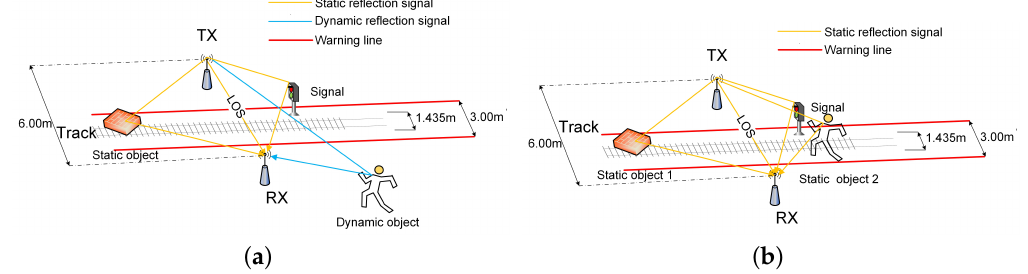
Figure 6. Foreign objects intrusion model. ( a ) Scene of foreign object movement. ( b ) Scene of foreign object